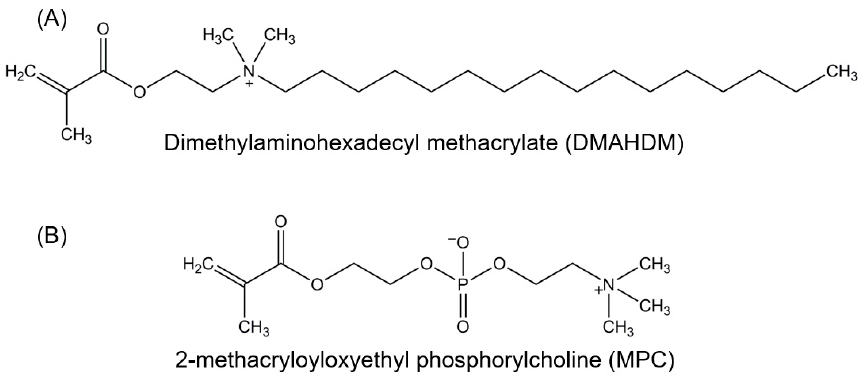
Figure 1. Chemical structures of bioactive monomers. ( A ) Antibacterial monomer dimethylaminohexadecyl methacrylate (DMAHDM), synthesized via a modified Menschutkin reaction; ( B ) Protein-repellent monomer 2-methacryloyloxyethyl phosphorylcholine (MPC).